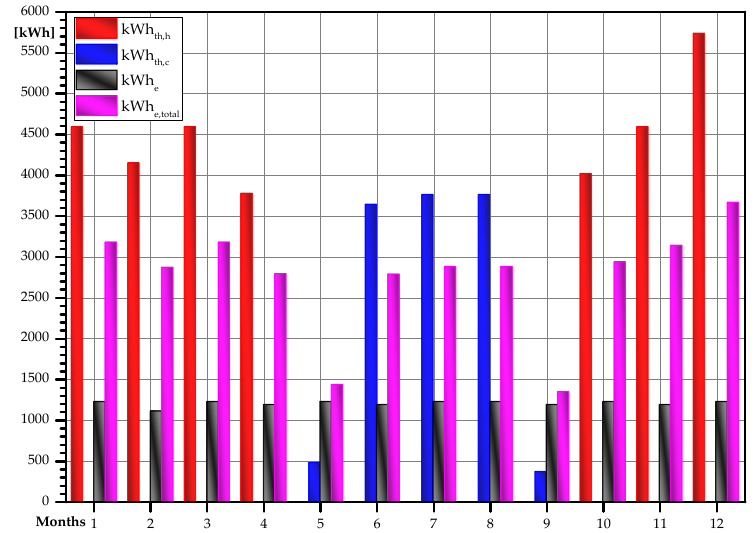
Figure 3. Allocation of the monthly energy consumption of the building for a typical year.